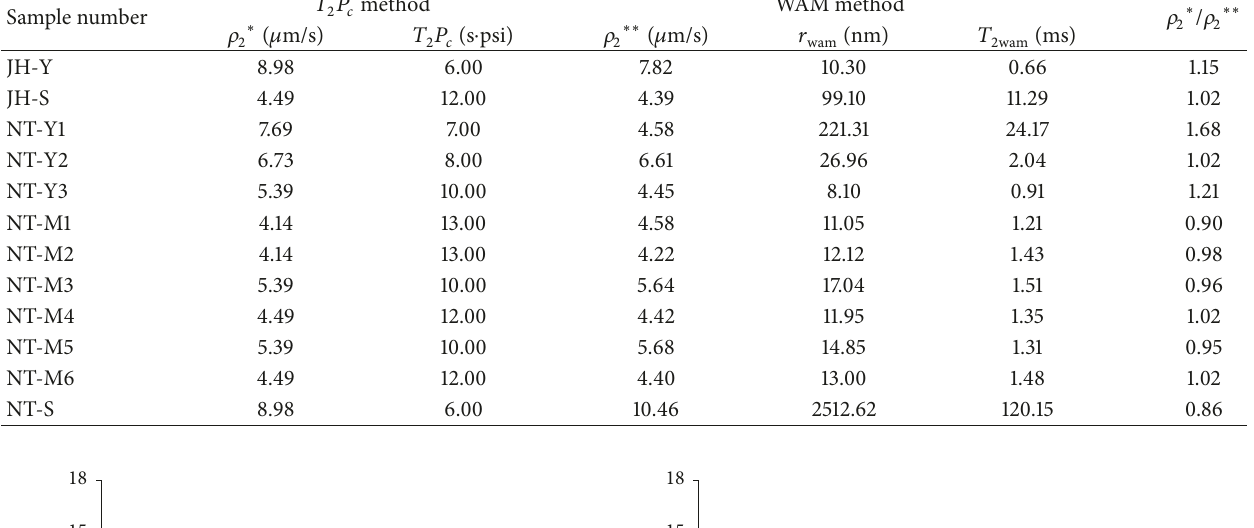
Table 6: Parameters derived from the methodsof 𝑇 2 𝑃 𝑐 and WAM.